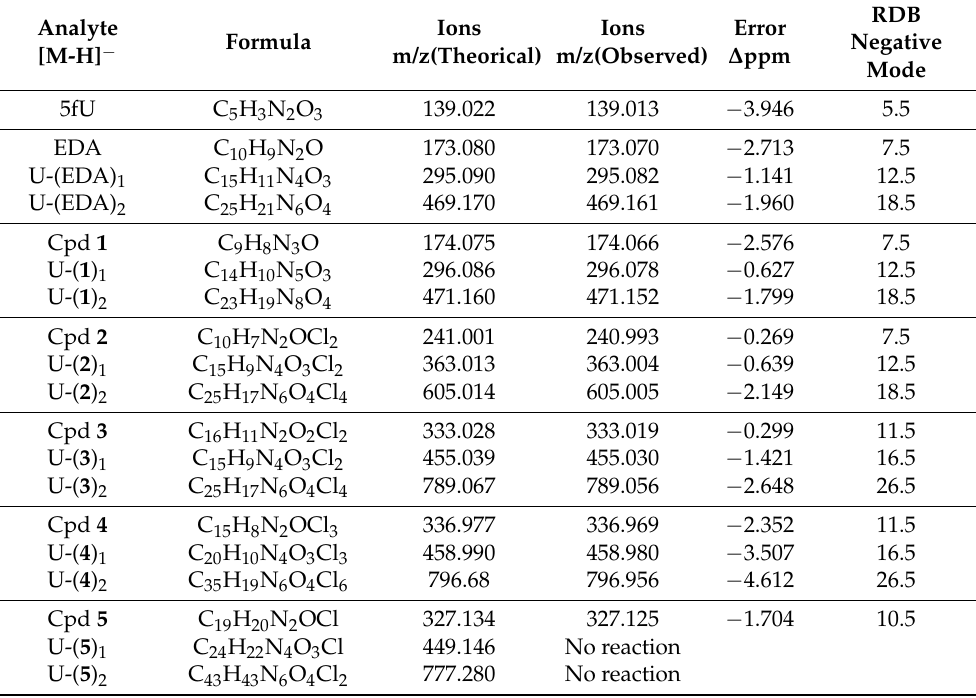
Table 3. HRMS data for the reaction of the studied products with 5-formyluracil